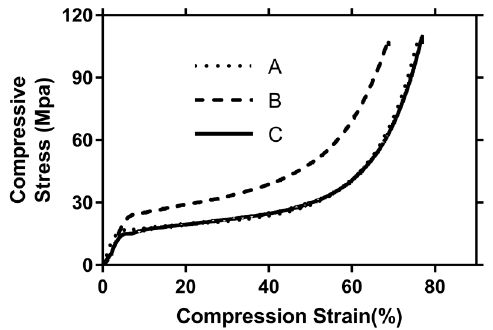
Figure 7. Compressive behavior of three foam samples (A, B, C) under uniaxial compression: Compression stress as the function of strain. Table 4. Stress levels for specific regimes and densification strain during uniaxial compression of Aluhab foam.